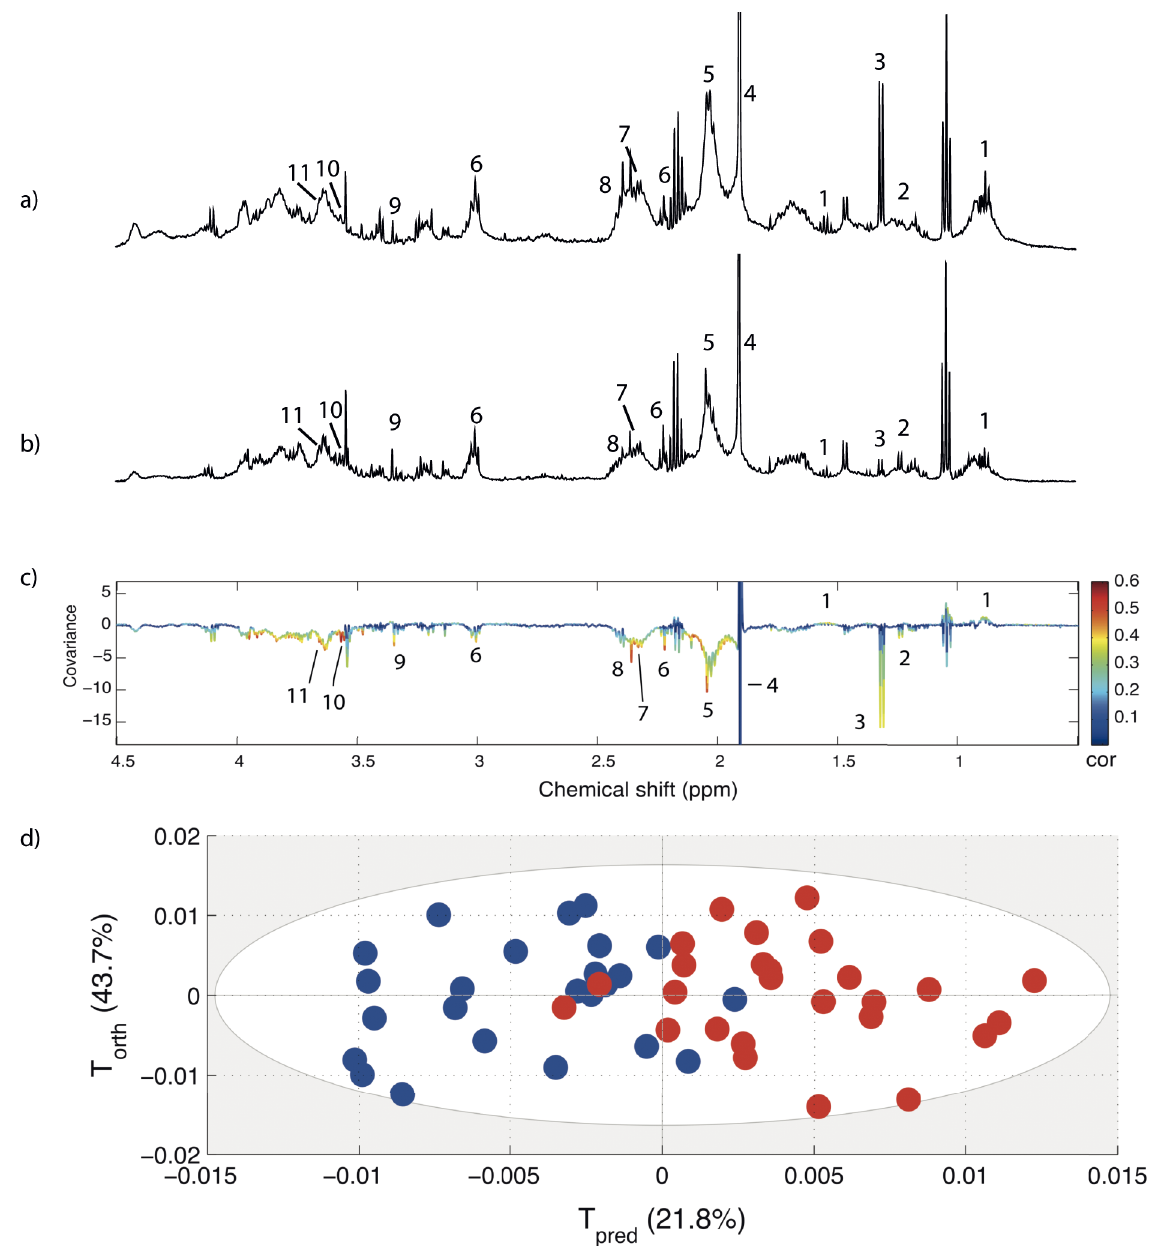
Fig 2. Examples of NMR spectra in saliva and OPLS metabolomic analysis. a,b) Representative 1 H-NMR spectra obtainedin (a) a control individualand (b) a case individual. c) Orthogonal projectionto latent structures (OPLS model)of 1 H-NMR spectra obtainedin saliva from periodontitispatients (red dots) and healthycontrols (blue dots) accordingto the predictive(Tpred) and not predictive (Torth) componentsobtainedfrom the OPLS model. d) OPLS loadingsplot showingthe discriminant metabolites between patients with periodontitisand controls. Variationsof metabolites are representedusing a line plot between0–9 ppm. Positive signals correspond to metabolites present at increasedconcentrations in the patient group. Negativesignals correspond to metabolitespresent at increasedconcentrations in the control group. The buckets are labelledaccordingto metaboliteassignment (1. butyrate; 2. fucose; 3. lactate; 4. acetate; 5. N-acetyl of glycoprotein; 6. GABA; 7. 3-hydroxybutyrate; 8. pyruvate; 9. methanol; 10. threonine;11.